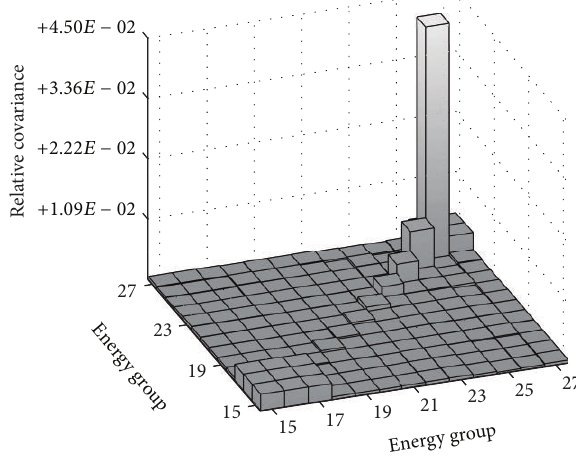
Figure 19: 𝜎 U 235 𝑓 covariance at infinite dilution.